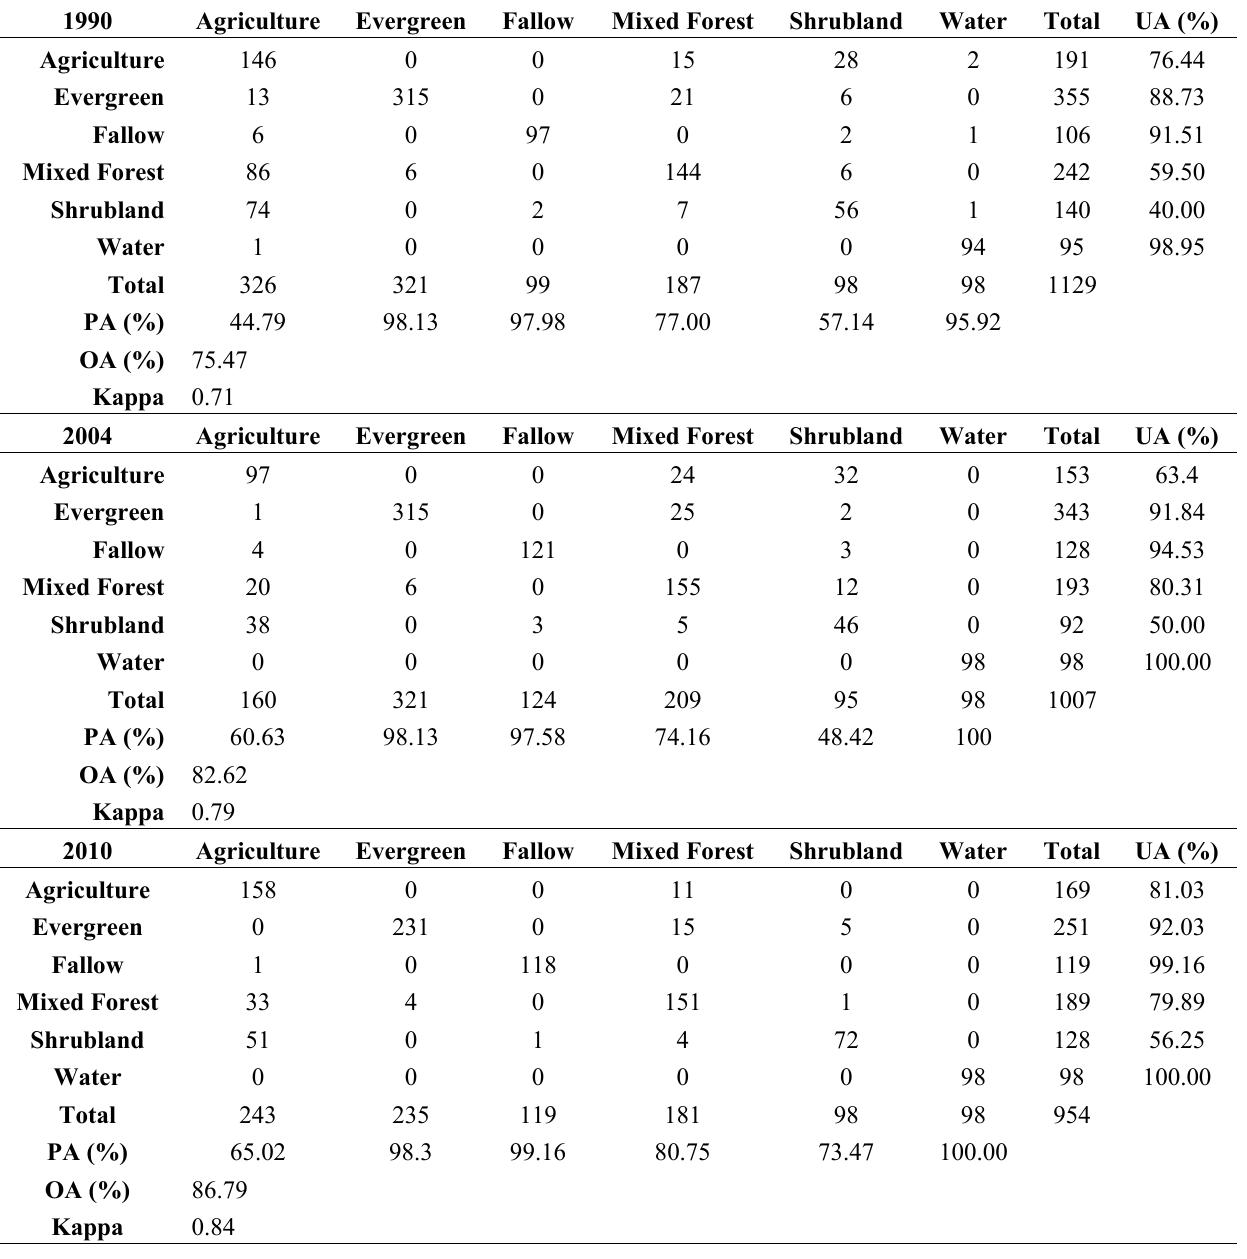
Table 2. Accuracy assessment of classification results based on confusion matrix for 1990, 2004 and 2010